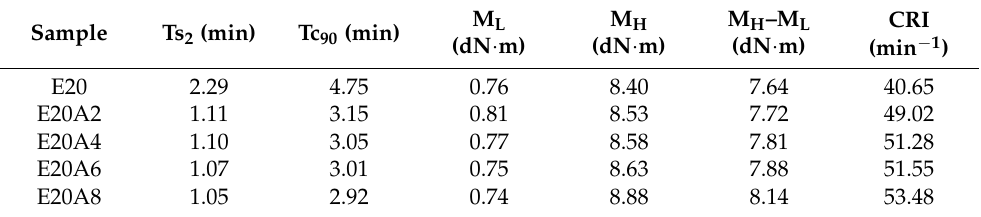
Figure 7. Rheometric curves of ENR/HNT composites filled with untreated and acid-treated HNT (un-deformed specimen). Table 2. Scorch time (ts 2 ), cure time (tc 90 ), minimum torque (M L ), maximum torque (M H ), delta torque (M H –M L ), and CRI for the ENR/HNT composites produced with untreated or acid-treated HNT.